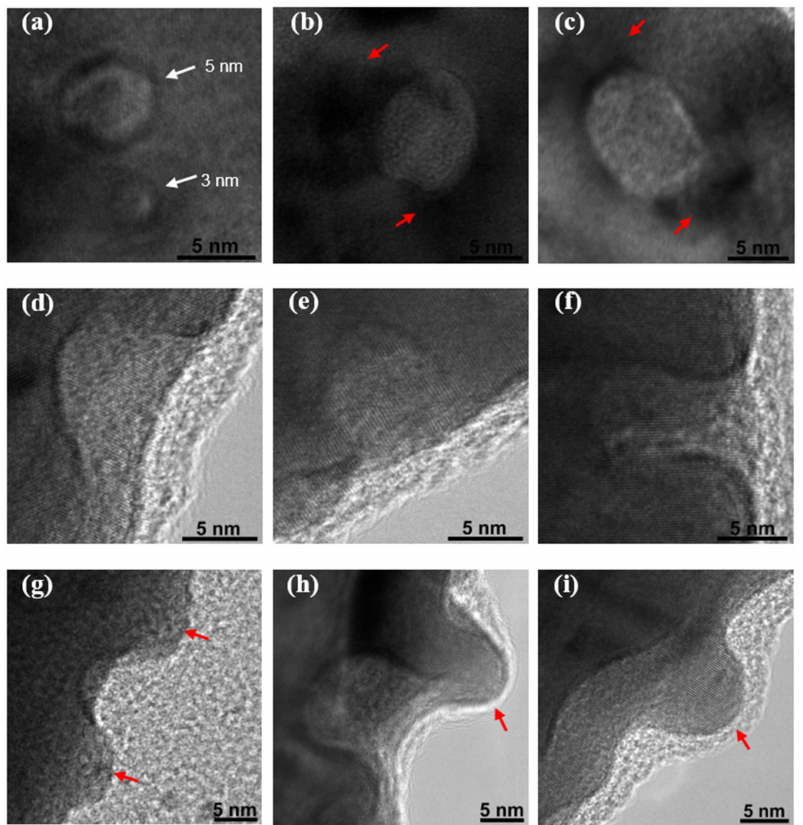
Figure 4. HRTEM images of typical features of a crater on irradiated NWs. ( a – c ) Craters on top surface. ( d – f ) Craters without protrusion on side surface, and ( g – i ) Craters with protrusion nearby. Red arrows point out protrusions on